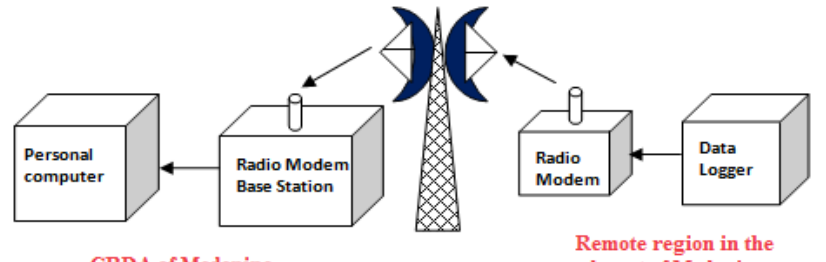
Figure 5. Scheme of field data transmission through the Radio